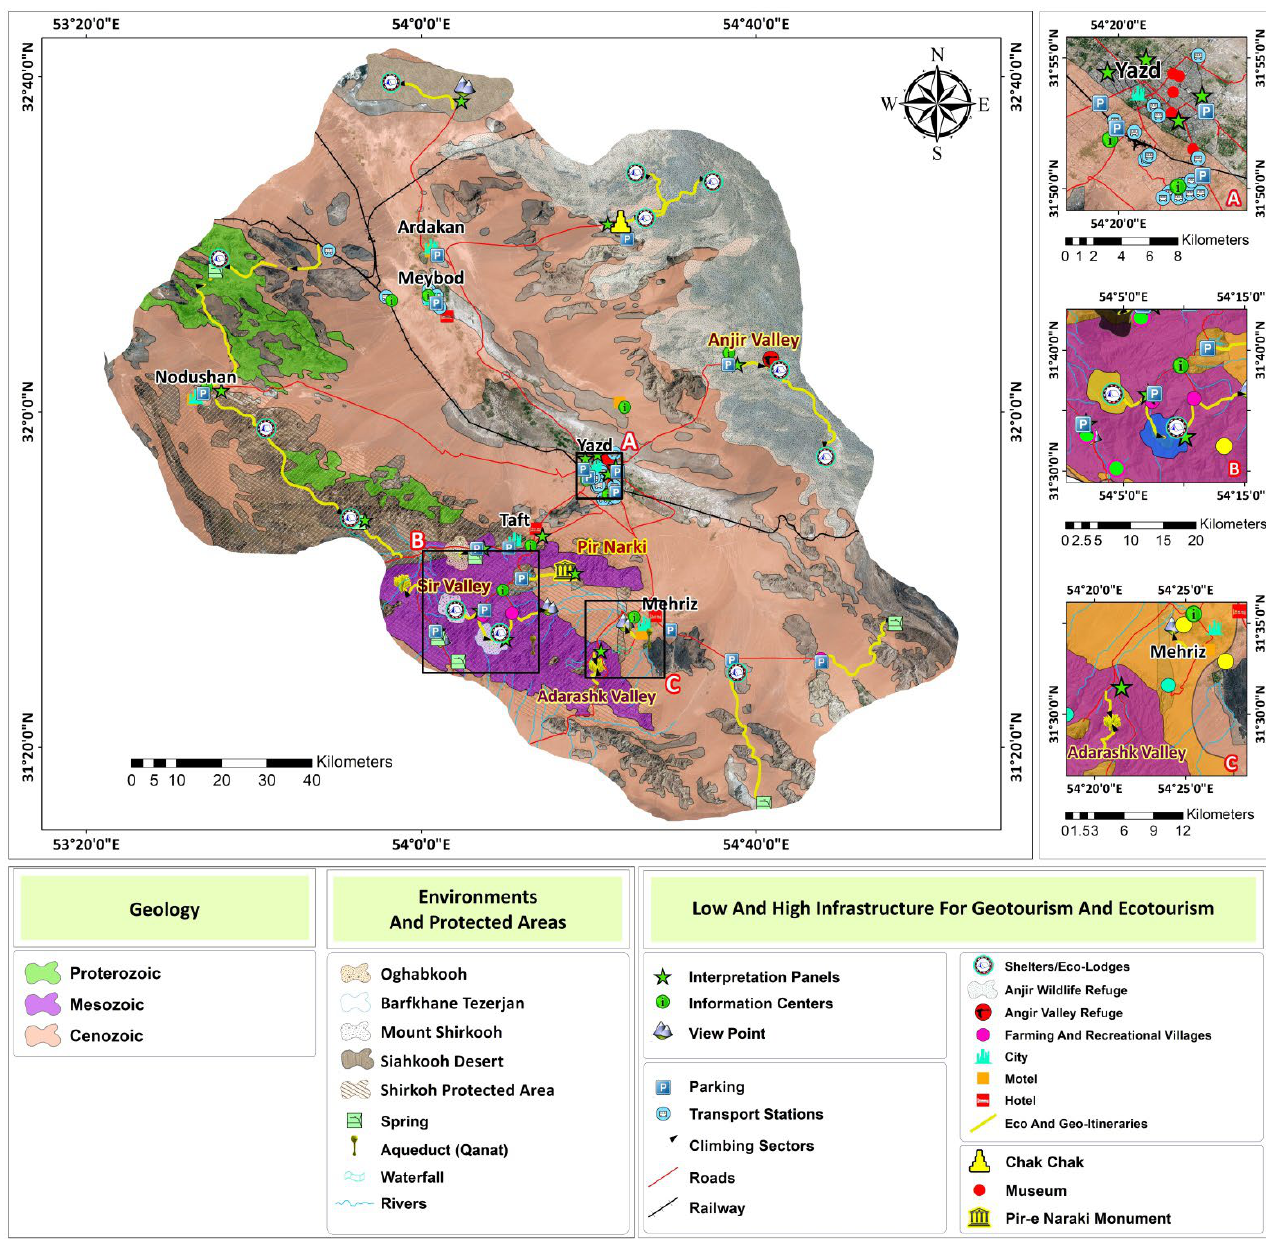
Figure 6. Low and high infrastructure, as well as adapted residential facilities, for the practice of local geotourism and ecotourism.